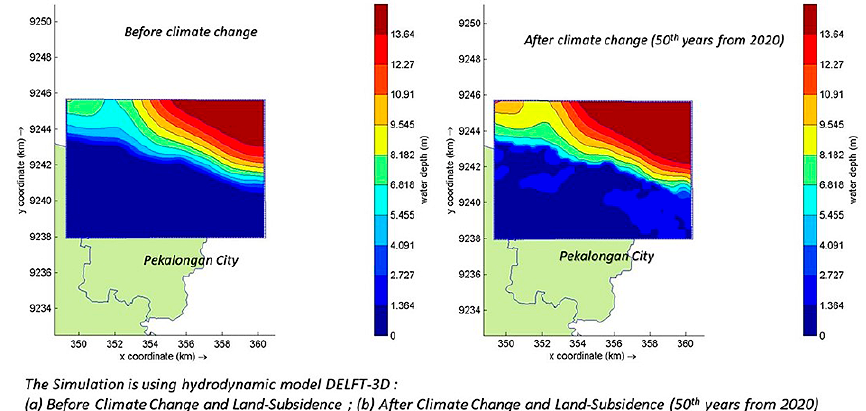
Figure 16. Result of Hydronynamic model before and After Climate Change and Land Subsidence